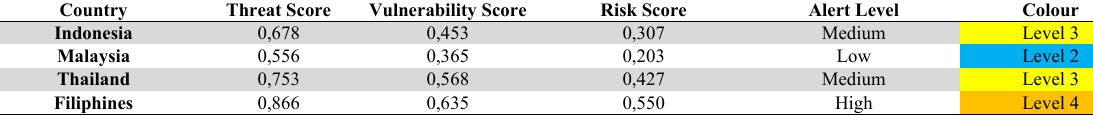
Risk Value toward the Islamic State (IS) Network in Southeast Asia